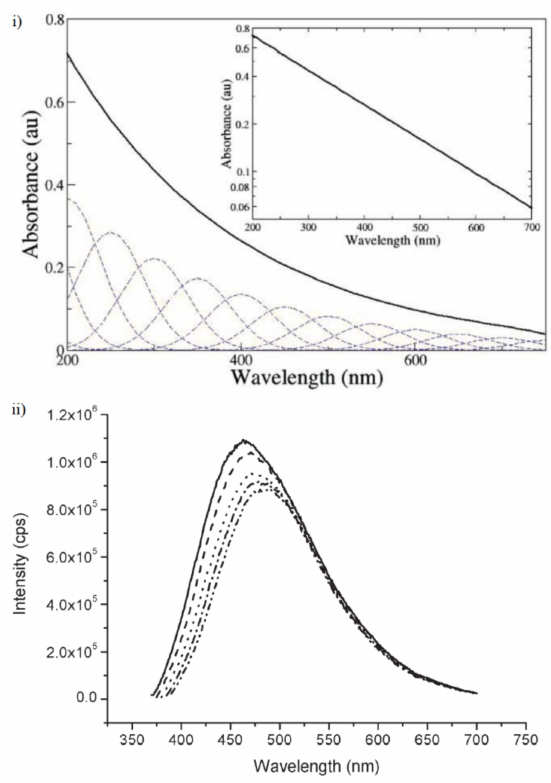
Figure 7. ( i ) An example of melanin’s UV-Vis absorbance spectrum. A log-linear plot of the data is depicted in the inset, demonstrating its exponential behavior. ( ii ) An example of the fluorescence emission spectra of melanin. The various dotted lines indicate the spectra obtained with variation of the laser pump energy (360 nm—solid line, to 380 nm—inner dot–dash line, in 5 nm intervals). Figures adapted from Ref. [69] with permission from The Royal Society of